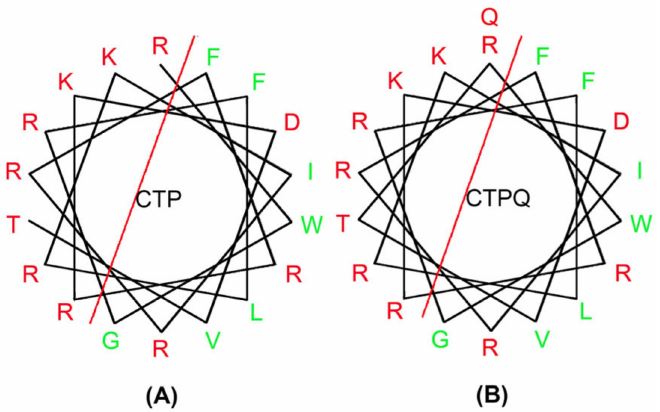
Figure 1. Helical wheel diagram of peptides ( A ) CTP (cathelicidin 2 (CATH2) and thymopentin (TP5)) and ( B ) CTPQ (addition of glutamine at the C-terminal of cathelicidin 2 (CATH2) and thymopentin (TP5)) using a website (https://www.bioinformatics.nl/cgi-bin/emboss/pepwheel (accessed on 12 February 2021)). The hydrophobic residues were shown in green, and the hydrophilic residues were shown in red. In addition, the red line separated the hydrophilic and hydrophobic